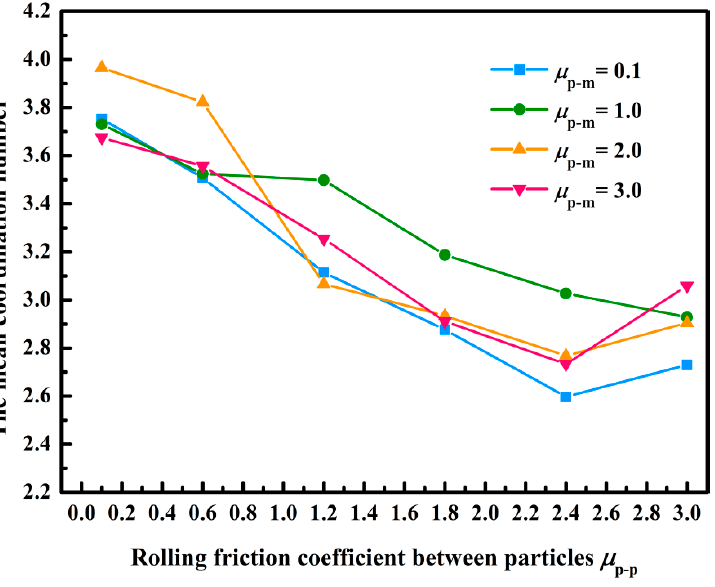
Figure 8. Impacts of the rolling friction coe ffi cient on average coordination number.